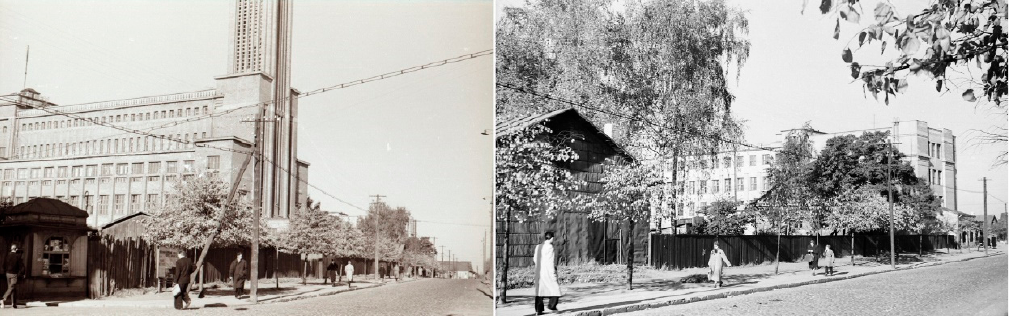
Figure 14. Žemai č i ų Street, around 1960 (photographer Stanislovas Lukošius, source: Kaunas City Museum).